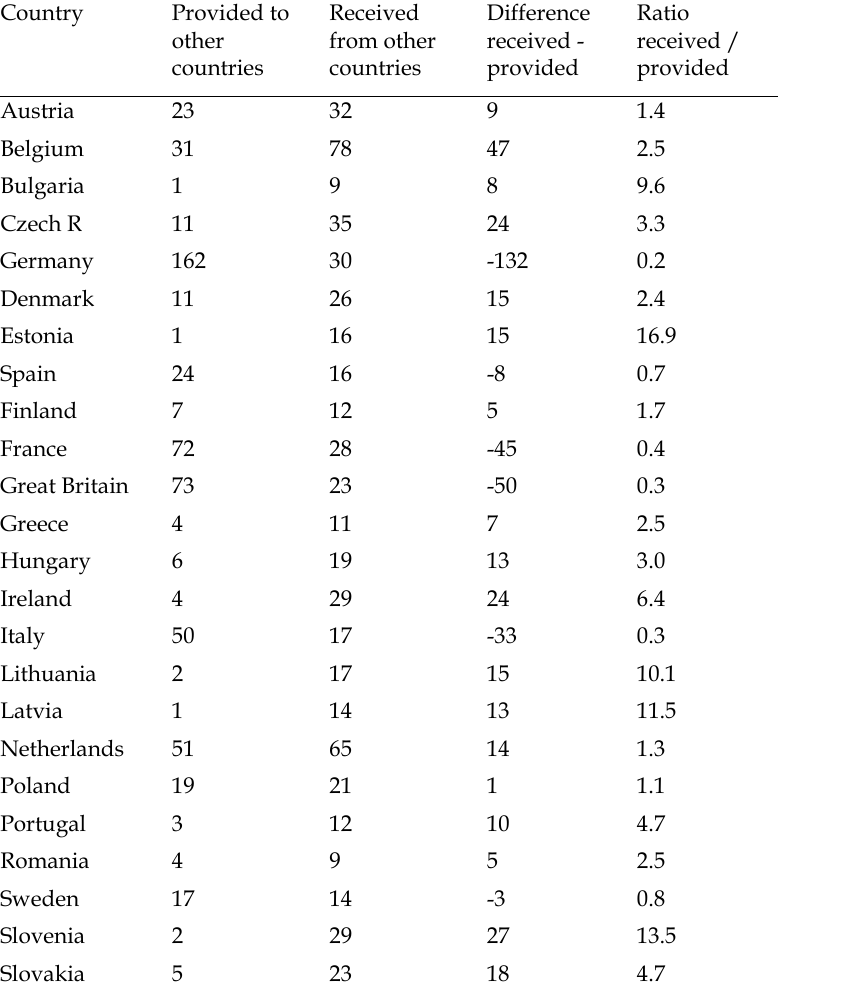
Table 8. Market potential provided to/received from other European countries (in millions of market potential units) Country Provided